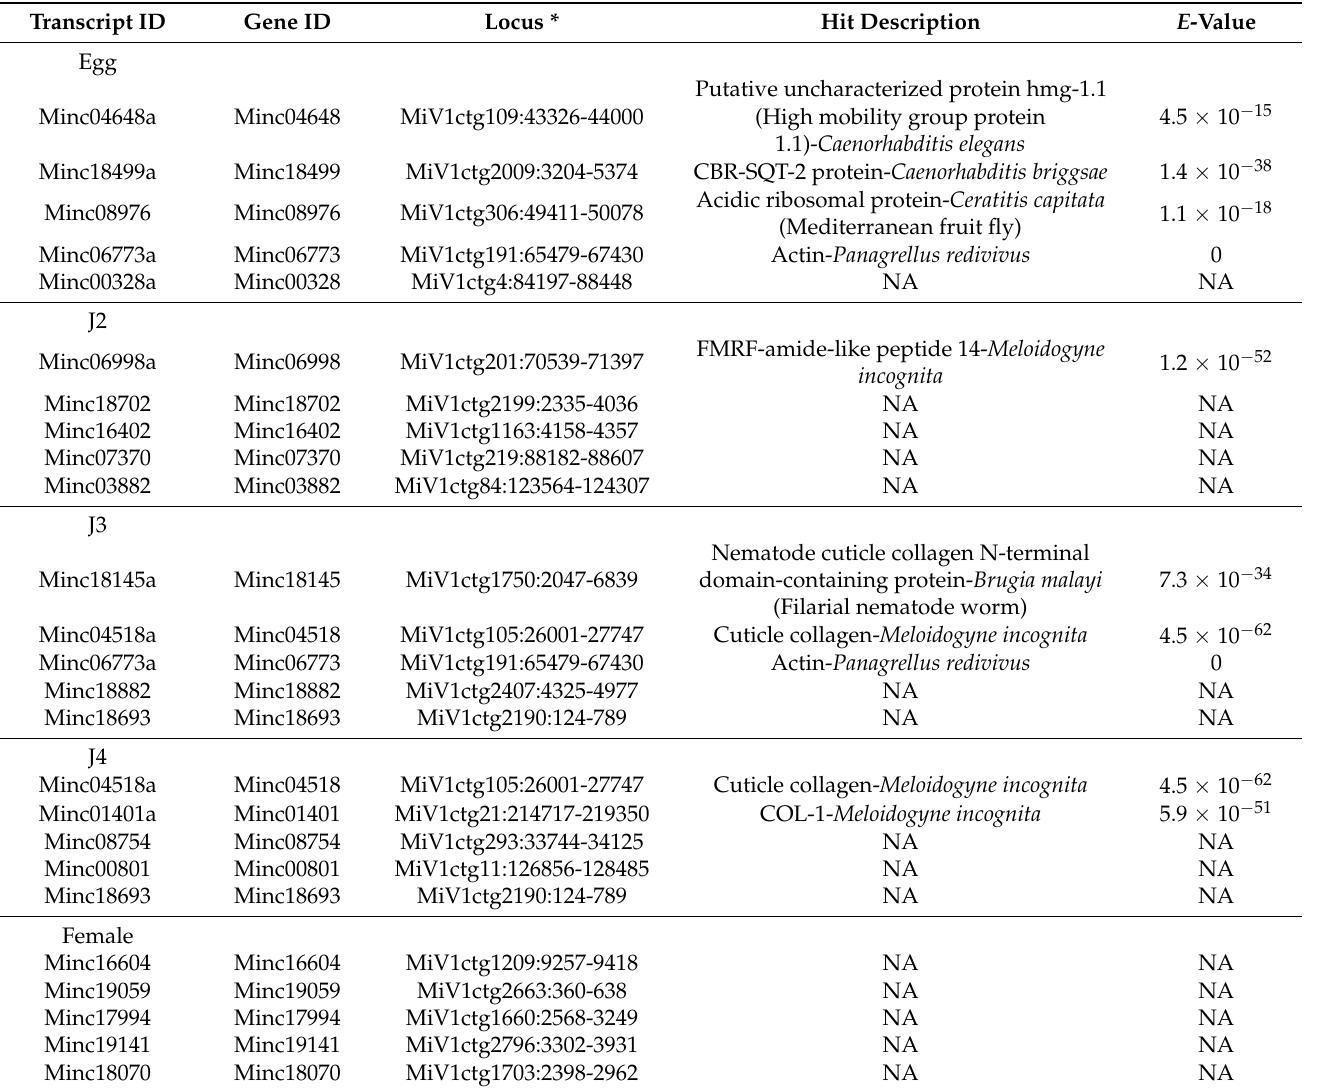
Table 3. Highly expressed mRNAs (top 5) from each developmental stage (egg, J2, J3, J4 and female).